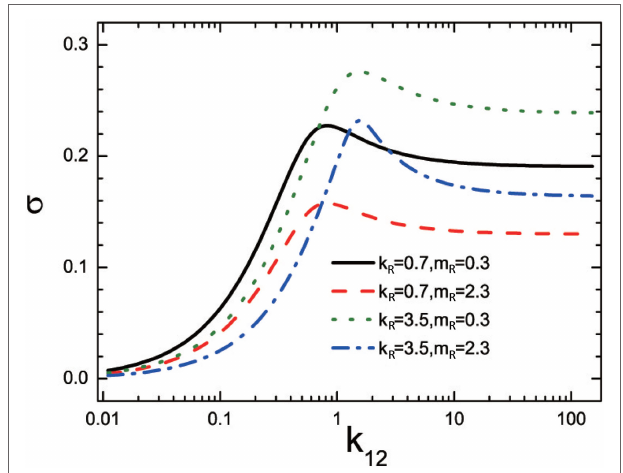
FIGURE 3 | Thermal conductance σ as a function of interfacial coupling k 12 in one-junction model, adapted with permission from the copyright holder (American Physical Society), Zhang et al. (2011). Here k L = 1.0 and m L = 1.0.